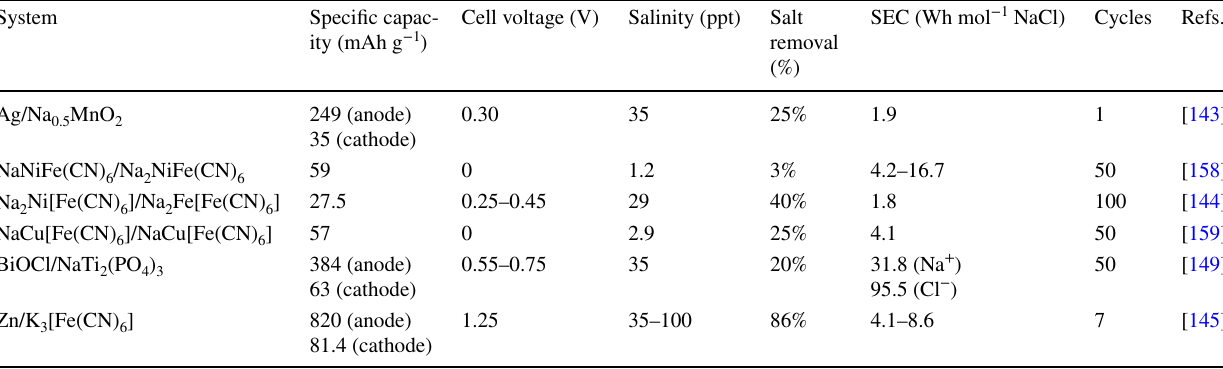
Table 2 Summary of performance metrics of typical desalination batteries